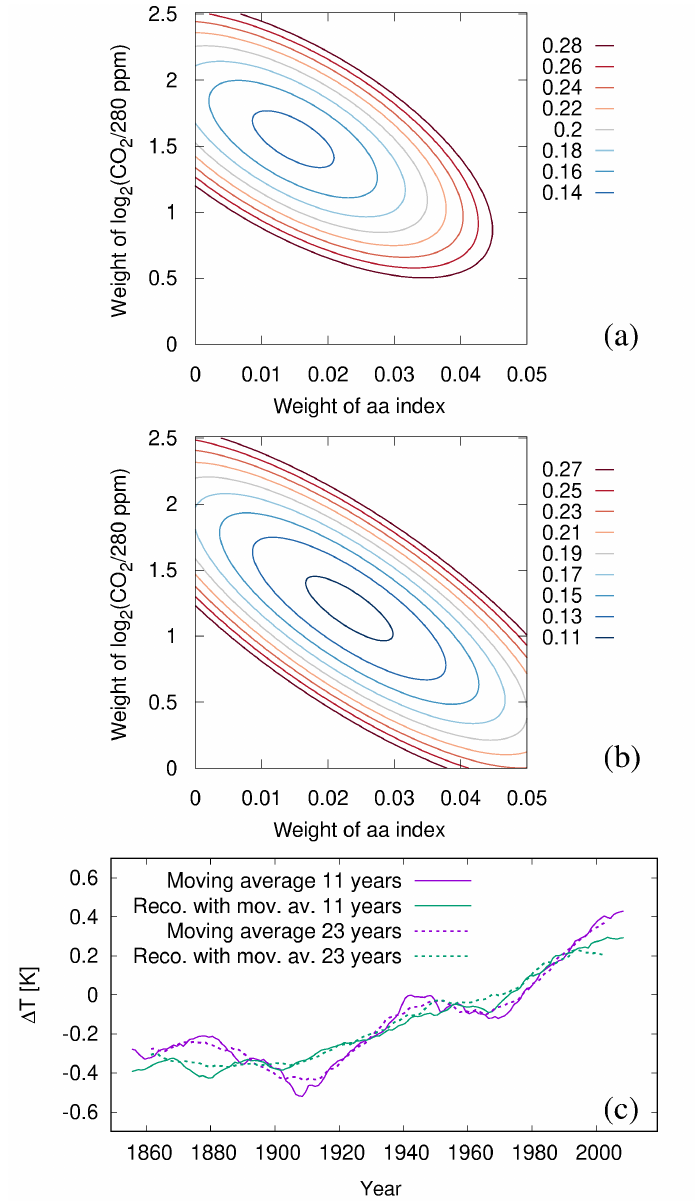
Figure 5. Regression analysis for the reduced data (end year 2013). ( a ) FVU in dependence on w aa and w CO for MAW = 11years, with FVU min = 0.134 reached for w aa = 0.0145K/nT and w CO 2 ( b ) The same for MAW = 23years, with FVU min = 0.105 reached for w aa = 0.0232K/nT and = 1.21K. ( c ) The 11-year and 23-year moving averages for the original ∆ T (purple) and for the w CO 2 reconstructed ∆ T (red) when using the optimized values of w aa and w CO